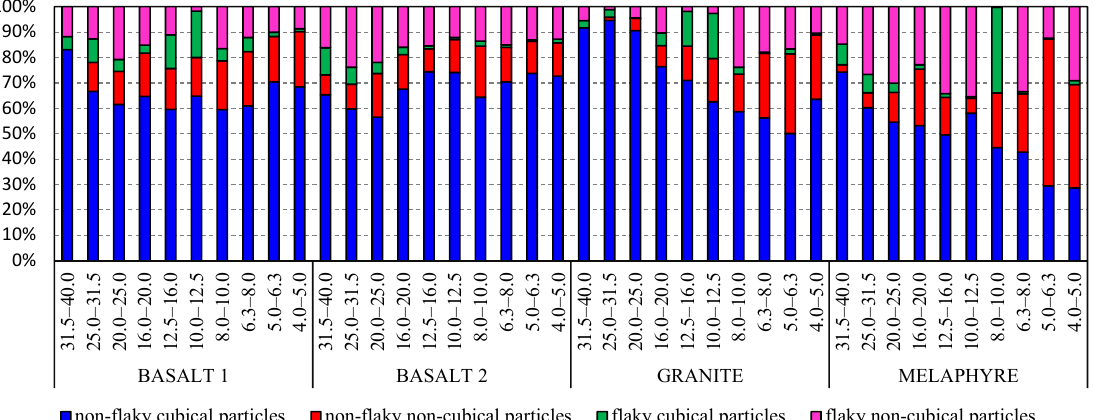
Figure 5. Analysis of shape and flakiness indexes for different size fractions.